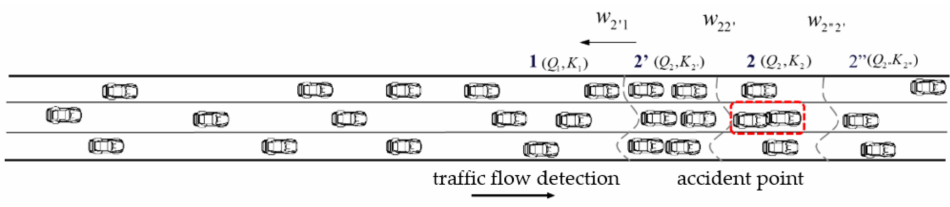
Figure 3. Traffic flow following an accident in the extra-long